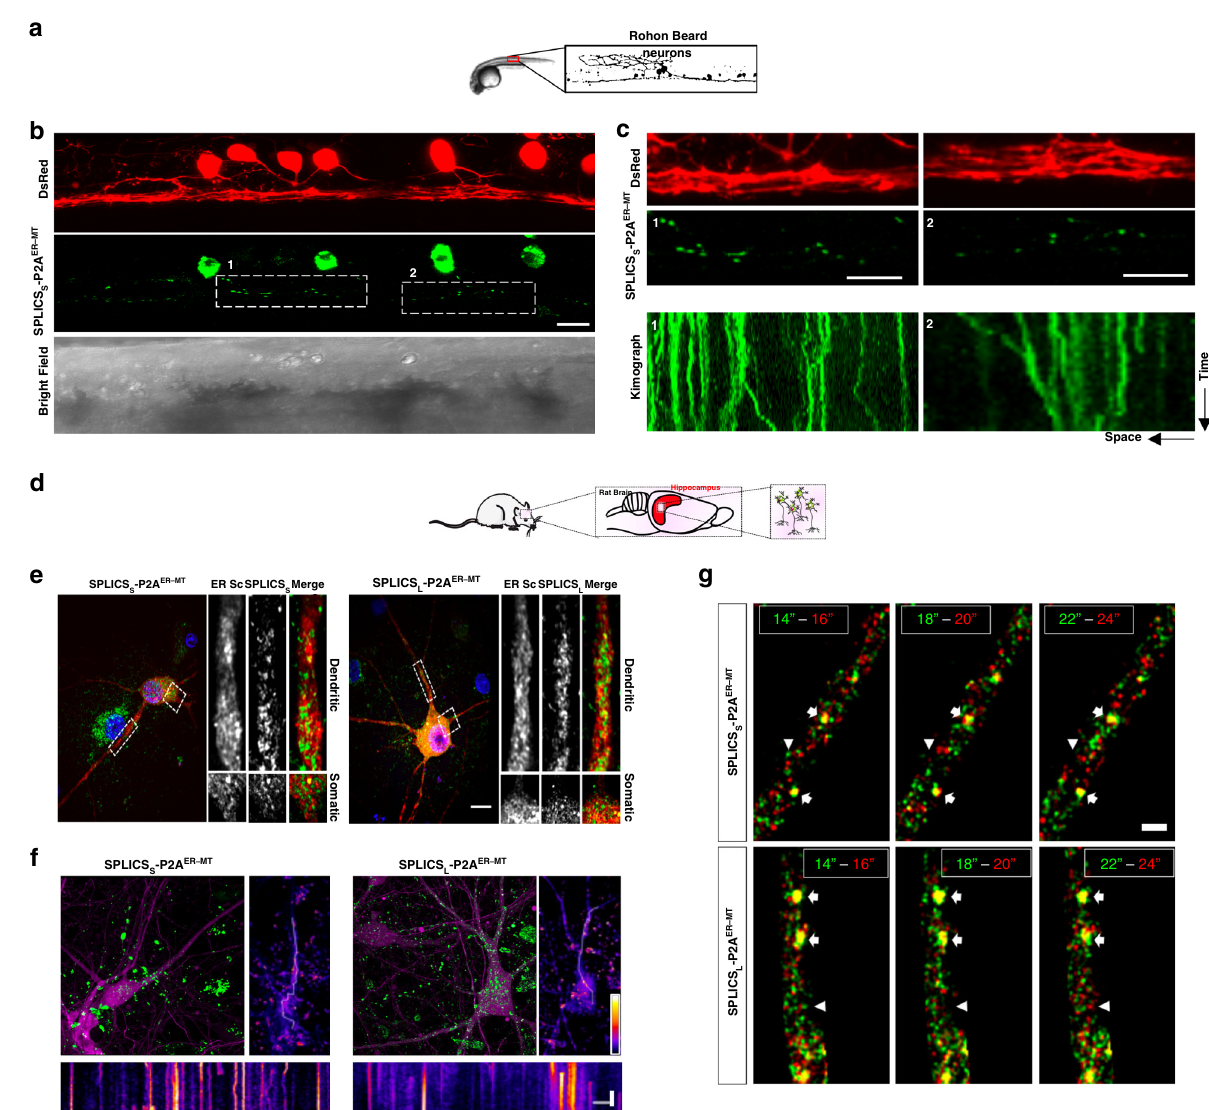
Fig. 7 ER – mitochondria contact sites are dynamic structures in vivo. a Live imaging of ER – mitochondria contact sites in zebra fi sh RB neurons. b Representative confocal images of SPLICS S -P2A ER – MT in RB neurons of 24 hpf s1102t:GAL4 living embryos injected with the pT2-DsRed-UAS-SPLICS S - P2A ER – MT construct. Rostral is on the right, dorsal on the top. BF Bright Field. c Magni fi cation of the areas shown in b and kymographs obtained by time- lapse recordings of the indicated region of the cell. The width of the kymograph represents the length of the axon recorded during the time-lapse, whereas the height re fl ects the elapsed time. Scale bar: 15 μ m. d Monitoring of ER – mitochondria contacts in rat hippocampal neurons by SPLICS S/L -P2A ER – MT . e ER – mitochondria wide and narrow contact sites are distributed throughout the entire somatodendritic and axonal compartments in hippocampal neurons. Rat hippocampal neurons were co-transfected on DIV 11 with the endoplasmic reticulum marker ER-mScarlet (ER-Sc) together with either the short- (8 – 10 nm) or long-range (40 – 50 nm) sensors, SPLICSs-P2A ER – MT (left) or SPLICS L - P2A ER – MT (right), respectively. On DIV 12, neurons were incubated with Hoechst 33258 and fi xed before confocal imaging. High-resolution Z-stacks were acquired in order to visualize nuclei (blue), ER (red), and ER – mitochondria contact sites (green). Selected dendritic (up) and somatic (bottom) regions are zoomed and shown on the right for a detailed view. Scale bar represents 10 µ m. f Short- or long-range SPLICS S/L -P2A ER – MT (green) were transduced on DIV 7 with rAAVs to convey sparse expression of RFP (magenta) 34 and on DIV 11 neurons were transferred to an imaging chamber containing CO 2 -independent CICM medium and a Z-stack was acquired in a spinning disk microscope and shown as Z-stack maximum projection for a general overview (upper-left panels). By using a single plane, a time series of the SPLICS L/S structures was acquired during 4 min at 0.5 Hz. Standard deviation analysis was applied to the image (upper-right panels, scale bars represent 10 μ m and the color table), which was used to identify mobile structures and to choose the path for its visualization in a kymograph (lower panels). The scale bars represent 60 s (vertical) and 10 μ m (horizontal). g ER – mitochondria contact sites dynamics suggest high turnover rates in hippocampal neurons under basal unstimulated conditions. Rat hippocampal neurons were infected on DIV 7 with rAAVs to convey expression of the long- or short-range SPLICSL/S (green and red). On DIV 11, neurons were transferred to an imaging chamber containing CO 2 -independent medium and a time series was acquired in a spinning disk microscope at 0.5 Hz (same neurons shown in Fig. 7f). Three examples of two consecutive time points spanning 2 s in between are shown in the combined images, where the green and red colors indicate the initial and fi nal time points, respectively. Arrows indicate hot-spots of long- lived SPLICS ER – MT signals and arrowheads indicate short-lived SPLICS ER – MT . The scale bar represents 2 μ m. (The Image in panel d is a previously created element from Servier Medical Art https://smart.servier.com under the Creative Commons Attribution 3.0 Unported